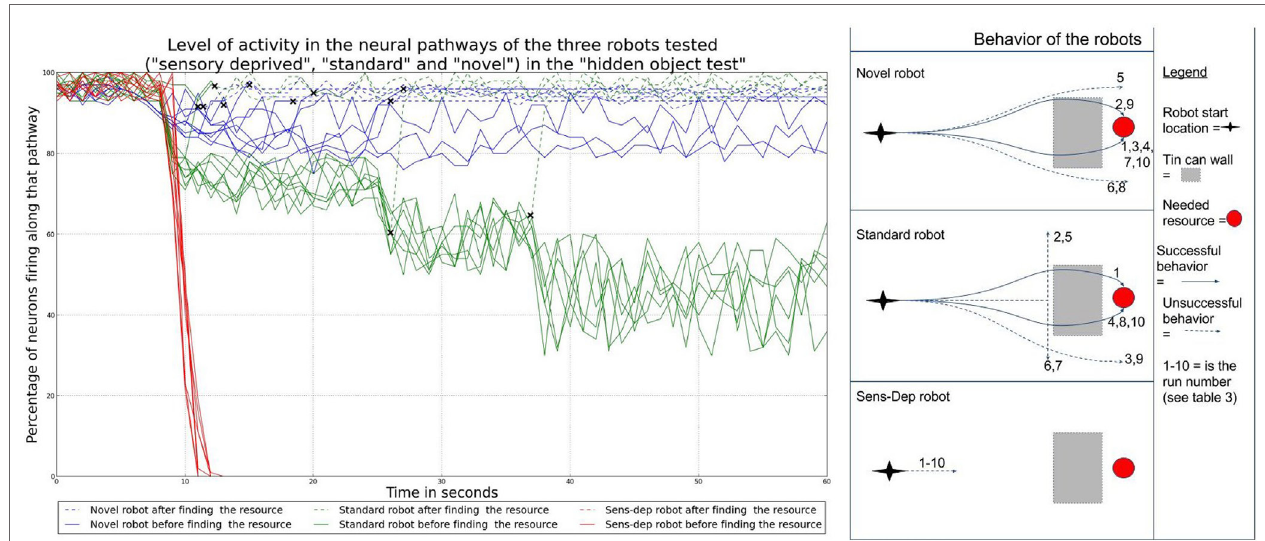
FigUre 12 | Overview of the behavior and neural activity of our three robots during the hidden toy test . The graph on the left shows the neural activity along the pathways associated with the hidden resource of each robot. Neural activity is measured as the percentage of active nodes. Crosses indicate the points at which each robot has found (i.e., detected) the hidden resource. Dotted lines are used to show the neural activity of the robot after this point. In most cases, the robot will detect a resource some seconds before it physically reaches it. As we can see, the perception of the hidden resource gives rise to increased neural activity. After the resource is hidden (at around the 10s mark), the pathway of the robot from the novel environment is the most active even without being able to see the resource: this robot has neural activity associated with the object and the behavior that it affords even after it has been hidden from view. On the right, the diagrams show the trajectories of the robots for each run. We can see that the robot from the novel environment was the most successful in finding the hidden